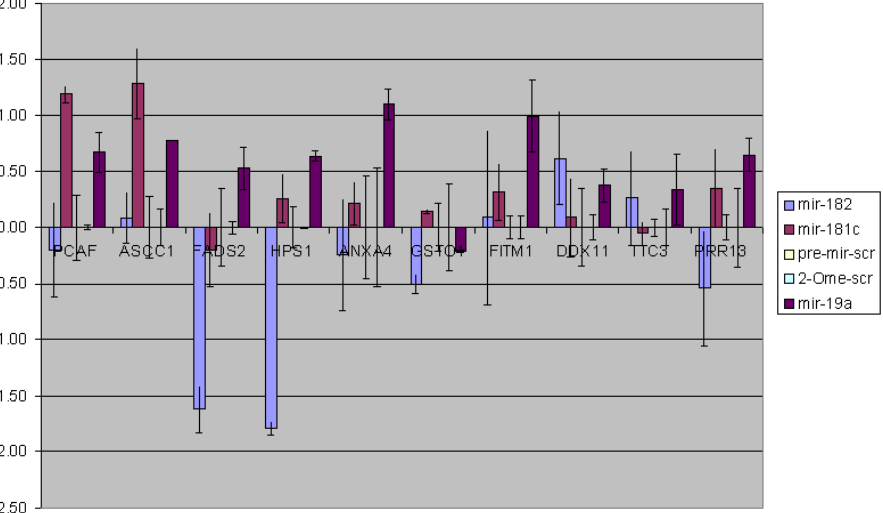
Figure 5. Experimental Validation of Highly correlated miRNA/transcript pairs. The above figure represents Ct scrambled -Ct pre-mir/2 9 -O- Me from three individual transfection experiments of pre- miR-181c , pre- miR-182 , 2 9 -O- Me- miR-19a , 2 9 -O- Me-scrambled and pre-mir-scrambled. PCAF, ASCC1, FADS2, HPS1, ANXA4, GSTO1, IFITM1, DDX11, TTC3 and PRR13 levels were determined after transfection.